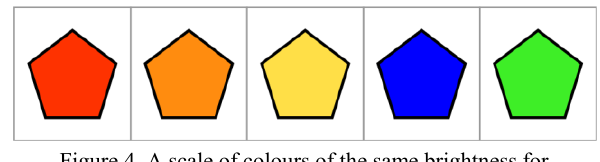
Figure 4. A scale of colours of the same brightness for additional selective emphasis of the features effected by the incident is available in a new version of the Australian All Hazard Symbology.